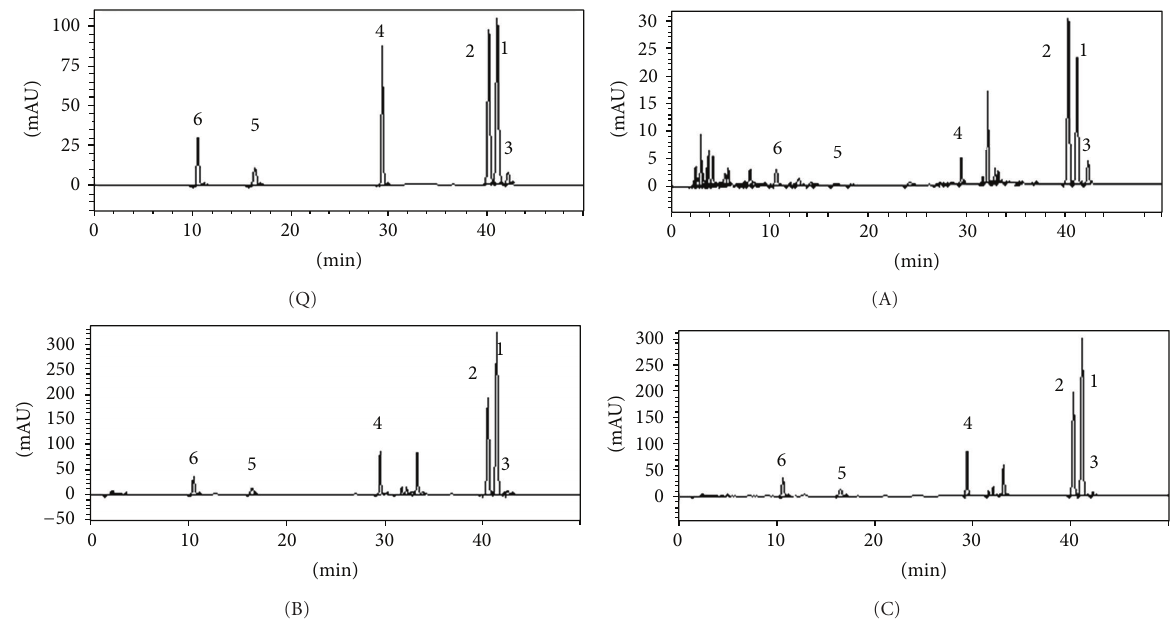
Figure 2: (Q) Chromatogram of mixed standard compounds. (A) Chromatogram of fronds of M. struthiopteris. (B) Chromatogram of rhizomes of M. struthiopteris. (C) Chromatogram of frond bases of M. struthiopteris. (1) Demethoxymatteucinol, (2) matteucinol, (3) matteuorien, (4) pinosylvin, (5) pinosylvin 3-O- 𝛽 -D-glucopyranoside, and (6) 5- 𝛽 -D-glucosyloxy-3-hydroxyl-trans-stilbene-2-carboxylic acid.